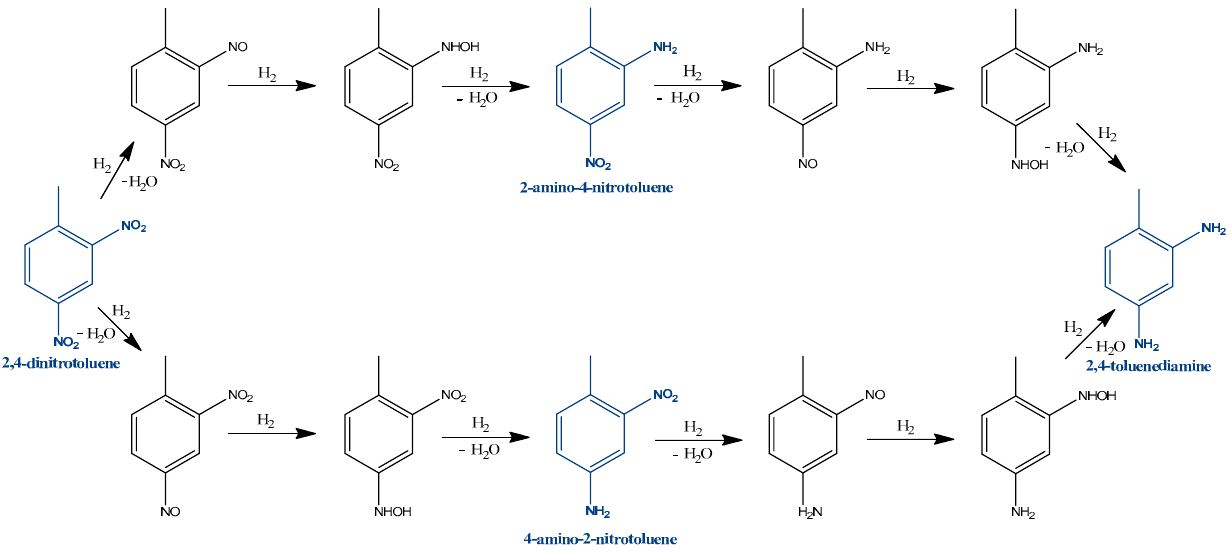
Figure 5. Reaction mechanism according to Hajdu et al. [44].